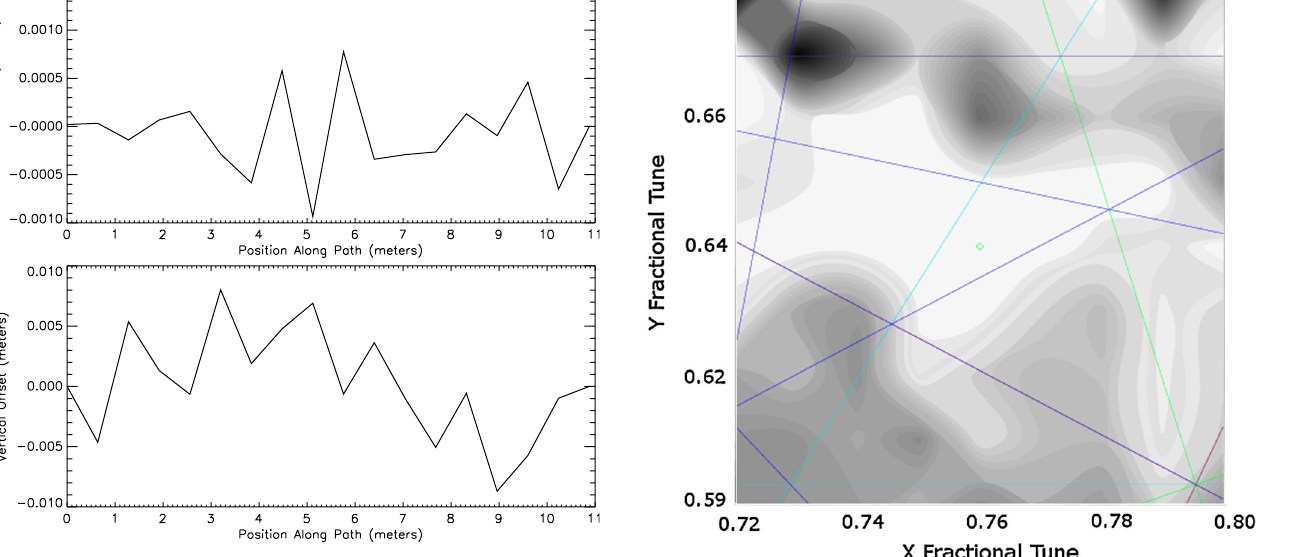
FIG. 5. (Color) A contour plot of the scanned tune space. Darker areas denote less of the beam surviving after 100 turns. The green e symbol represents the location of the ideal tunes. Superimposed are the resonance lines up to sixth order, red indicates 2nd order, orange indicates third order, green indicates fourth order, light blue indicates fifth order, and dark blue indicates sixth